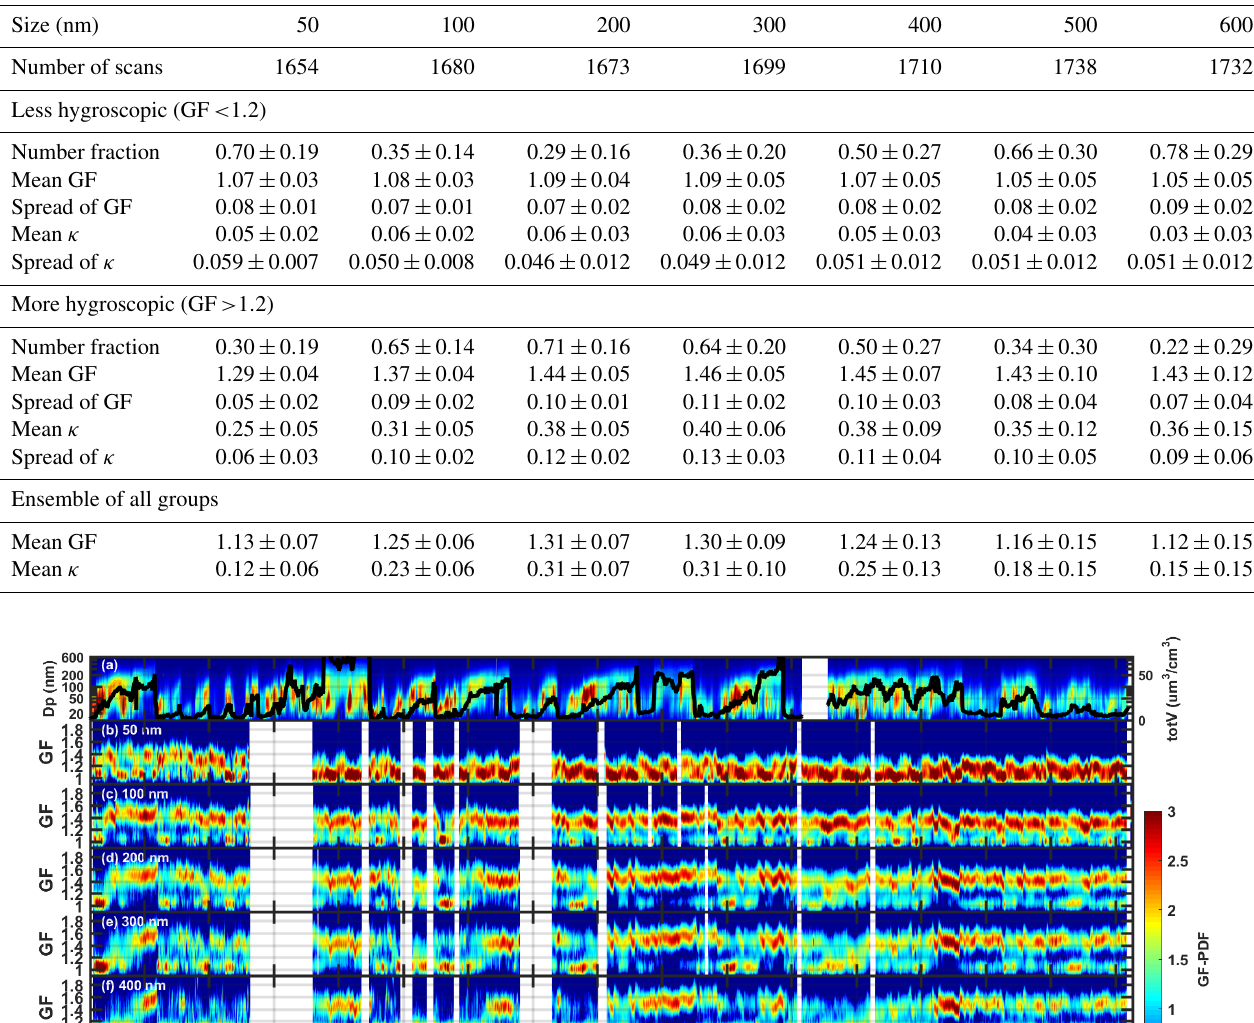
Table 2. Summary of the HTDMA measurements of hygroscopic growth at 85% RH.